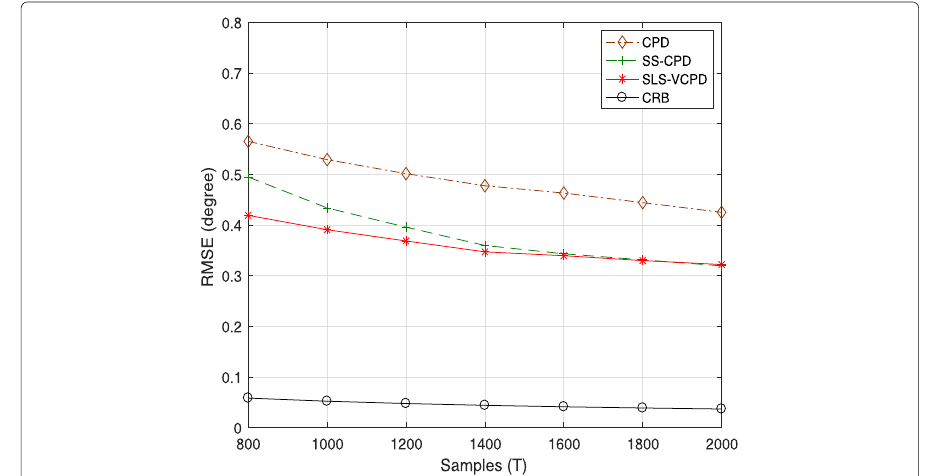
Fig. 12 RMSE versus the number of samples for ten sources with M = 6 and T =